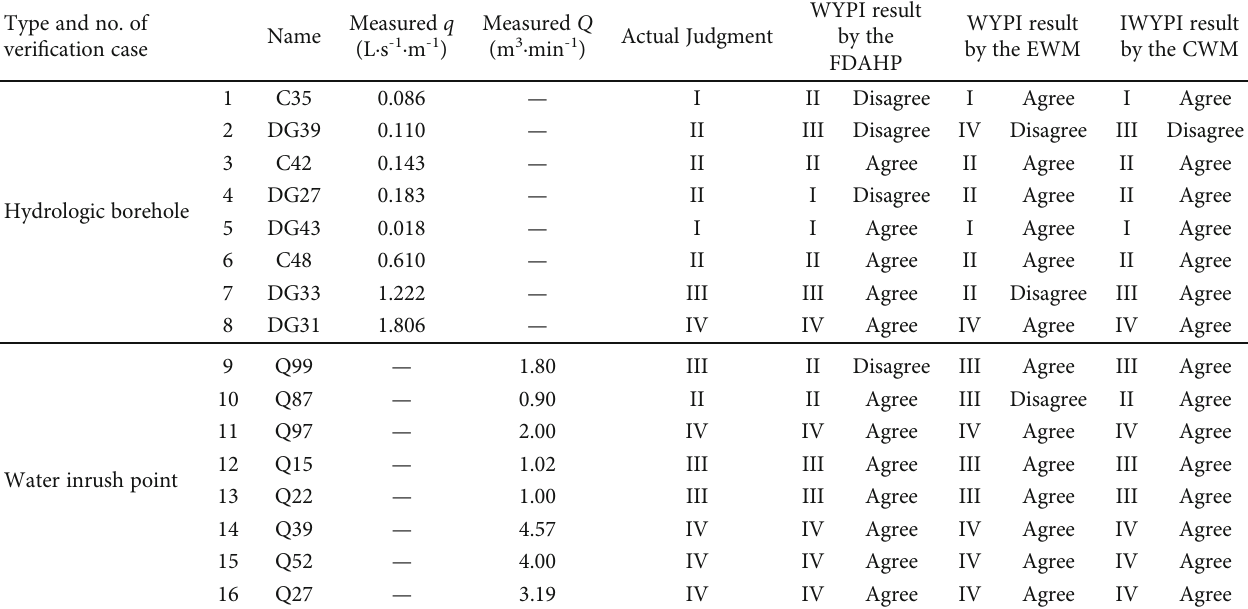
Table 8: Validation between the evaluation results and actual results. Type and no.